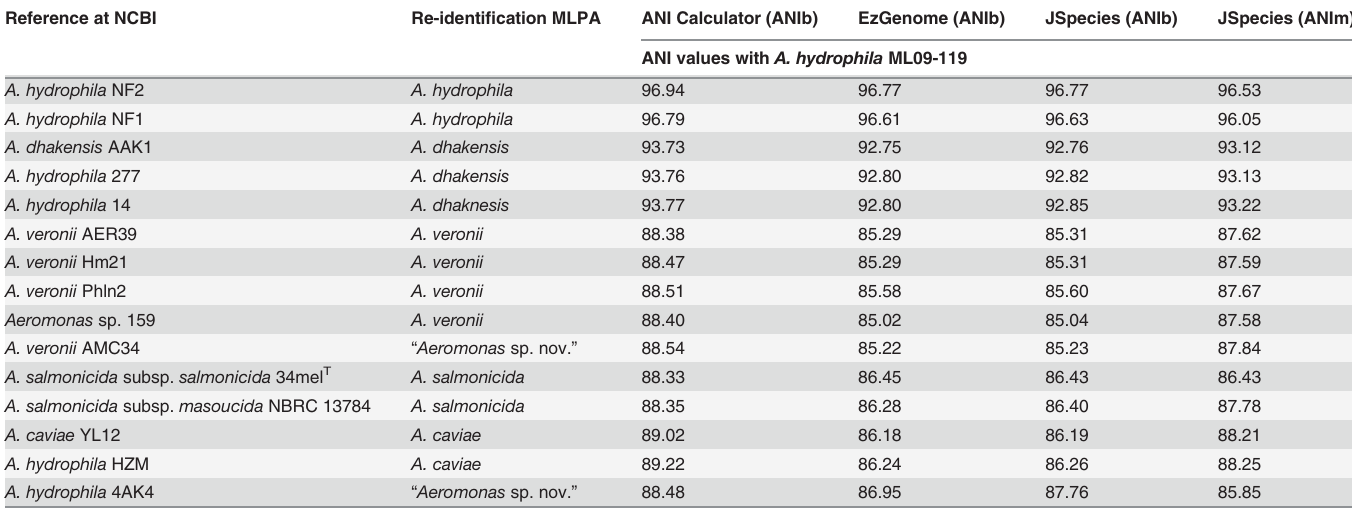
Table 3. ANI results in function of the employed calculating tool of 15 selected Aeromonas genomes against A. hydrophila strain ML09-119. Reference at